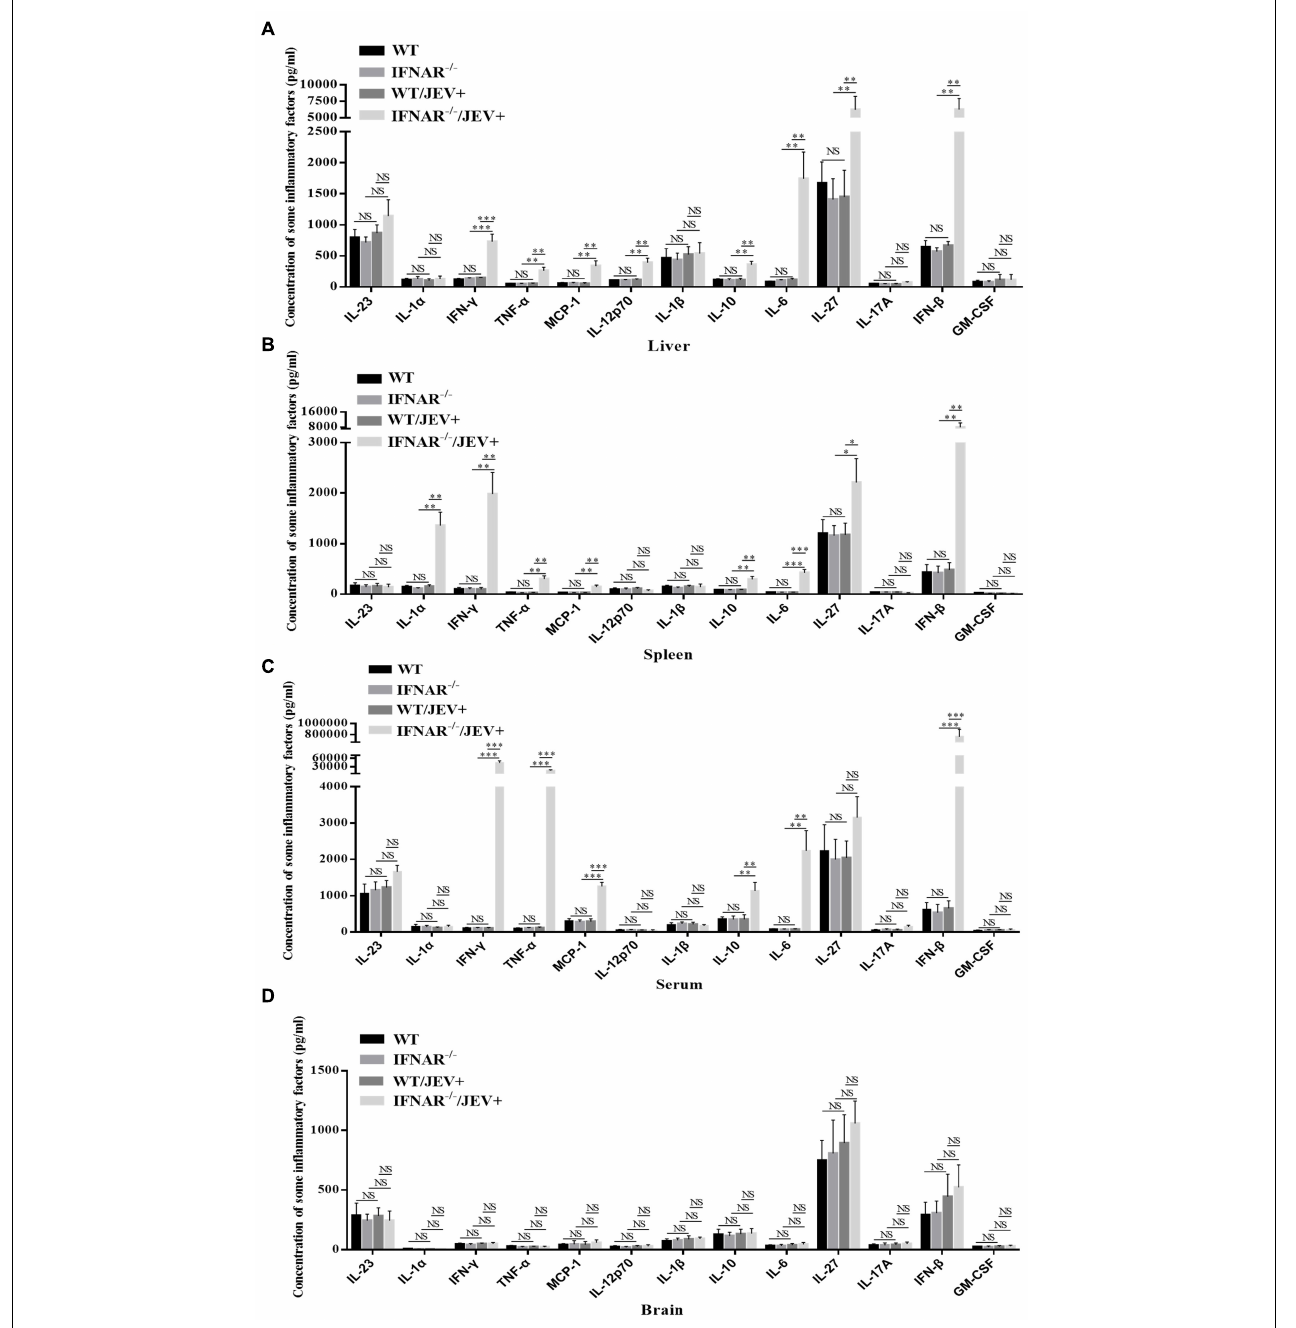
FIGURE 6 | SA14-14-2 strain infection induced significant up-regulation of inflammatory cytokines in IFNAR − / − mice. The concentration of inflammatory cytokines in the liver (A) , spleen (B) , serum (C) , and brain (D) were measured at 4 dpi by using a LEGENDplexTM Mouse Inflammation Panel (13-plex) with a filter plate (BioLegend). All the data represent mean ± SD of biological triplicates from at least three independent experiments. The Student’s t -test performed statistical analyses. ∗ P < 0.05, ∗∗ P < 0.01, ∗∗∗ P < 0.001, NS, no